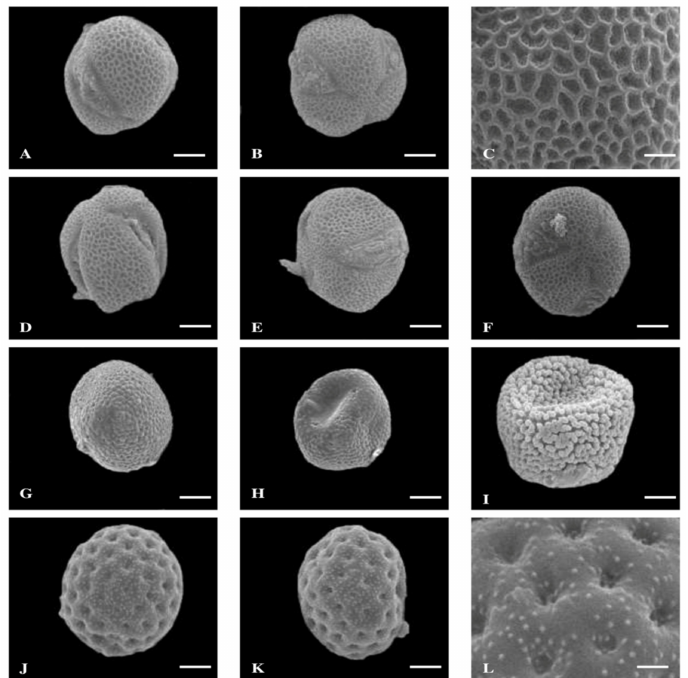
Figure 2. SEM images of pollen grains (Equatorial and Polar axis) and pollen surface ornamentation ( A – C ), The scale bar represents 5 µ m for Achyranthus aspera ( D – F ), 5 µ m for Aerva javanica ( G – I ), 10 µ m for Amaranthus graecizans ( J – L ), and 5 µ m for Asphodelus tenuifolius